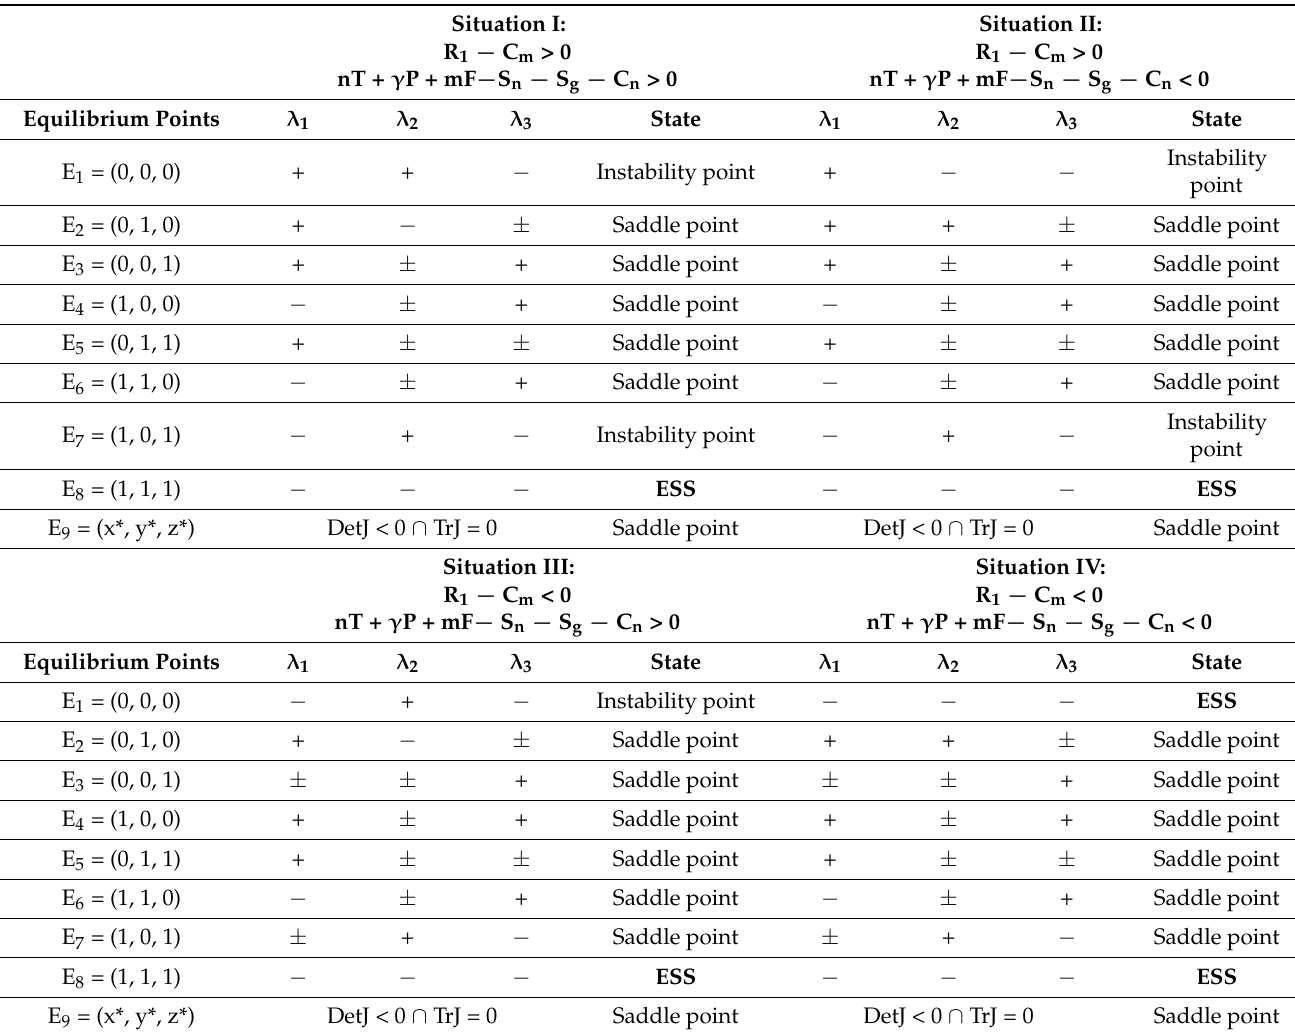
Table 4. Stability of the replicated power system. Situation